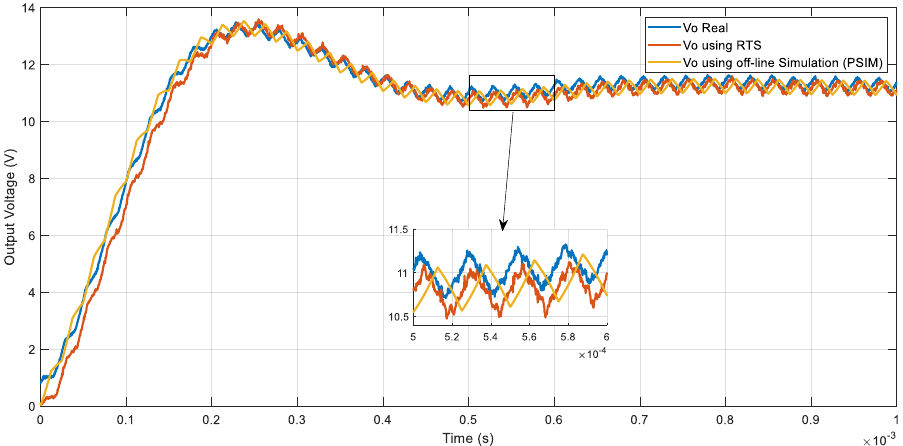
Figure 15. Output voltage of the real buck converter: real-time simulation and PSIM. Table 7. Mean Absolute Error (MAE) between the real buck converter and simulation platform. Signal